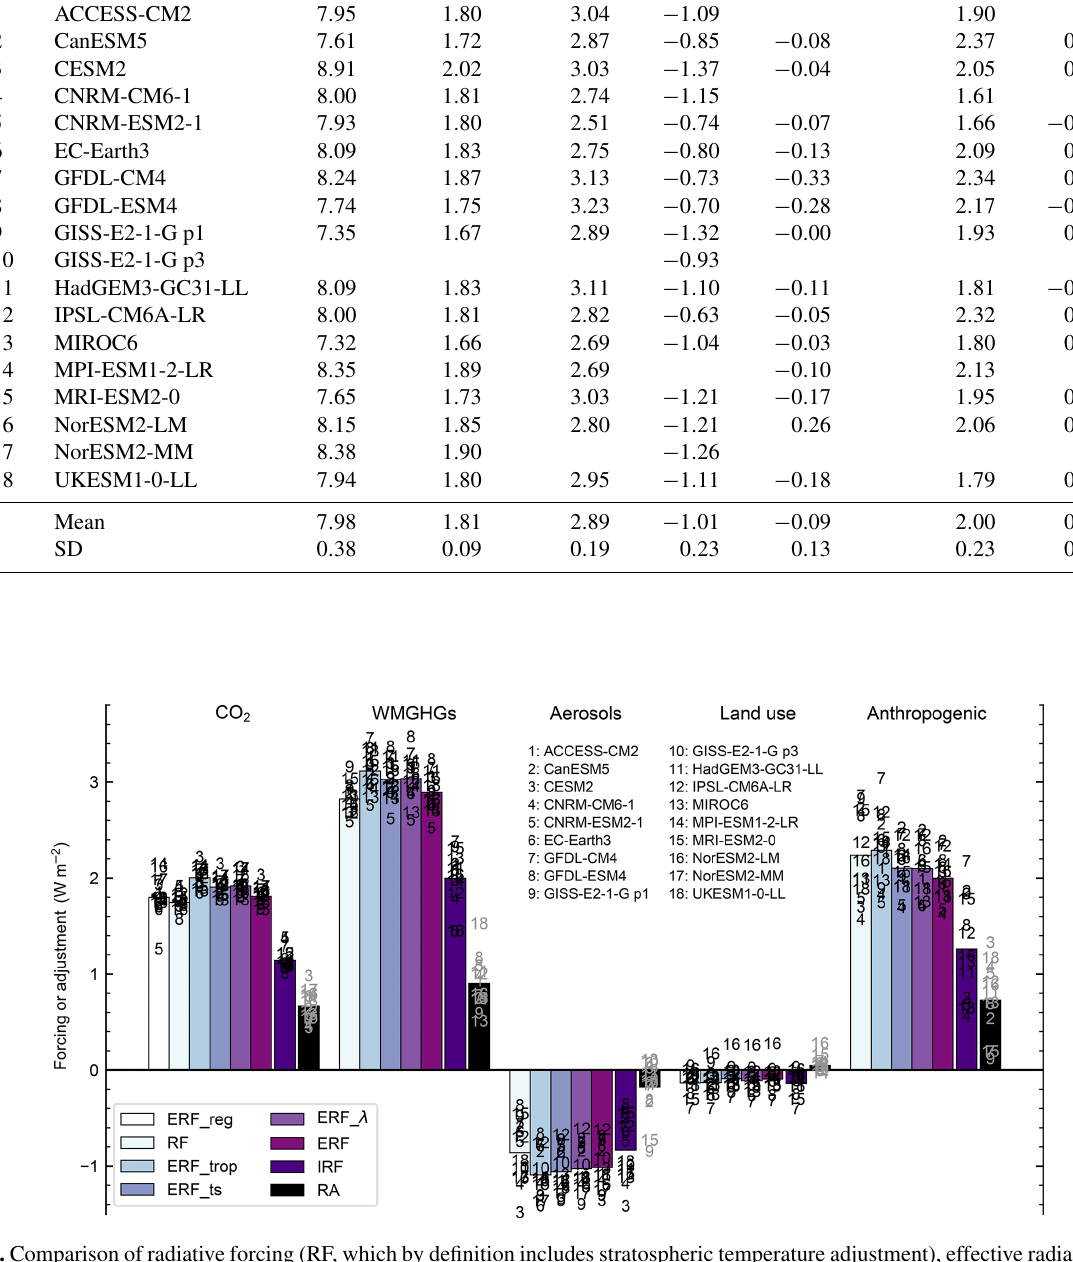
Figure 1. Comparison of radiative forcing (RF, which by definition includes stratospheric temperature adjustment), effective radiative forcing with tropospheric correction (ERF_trop), effective radiative forcing with land surface kernel correction (ERF_ts), feedback-corrected ERF (ERF_ λ ) and fixed-SST ERF. For CO 2 forcing, ERF from a Gregory regression (ERF_reg) from each model’s corresponding abrupt-4xCO2 CMIP simulation is also given. The ERF is compared with the IRF and adjustments (RA) for each of the present-day RFMIP-ERF time-slice experiments (1 . 4 × CO 2 is shown instead of 4 × CO 2 for better comparison with other forcing agents). Individual models are